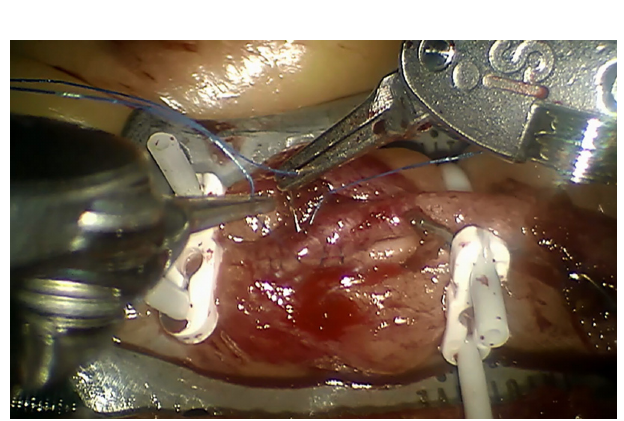
Fig. 4 - Last stitch in LIMA-LAD